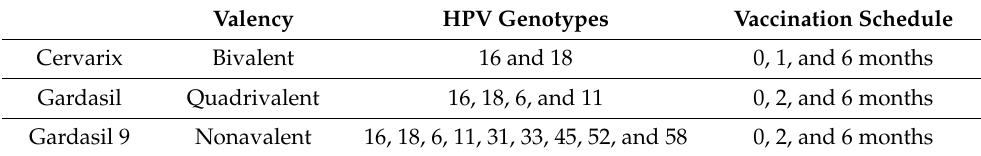
Table 1. A comparison of HPV vaccines. Valency HPV